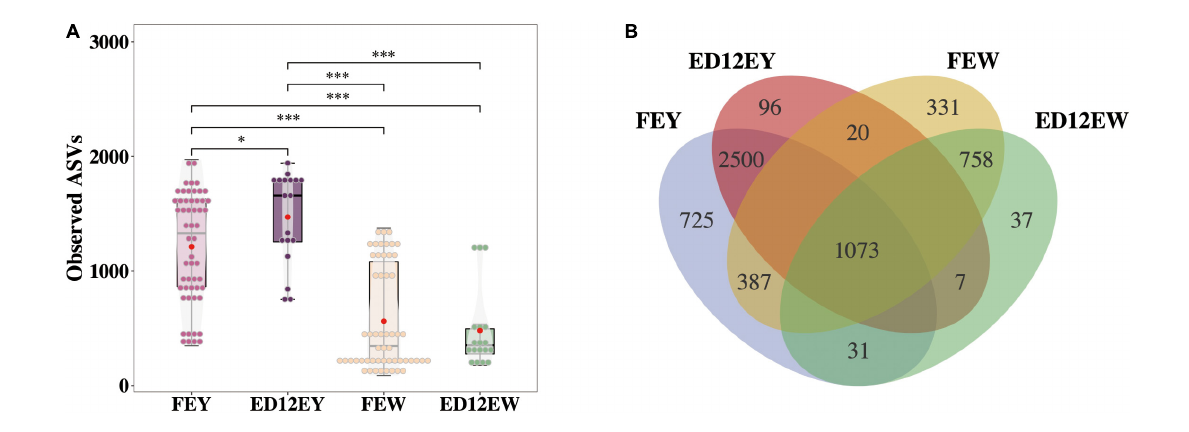
FIGURE2 The number of amplicon sequence variants (ASVs) and the shared ASVs in different groups. (A) The boxplot depicts the total number of ASVs detected in each group. (B) A Venn diagram demonstrates the core ASVs among four groups. * P < 0.05, *** P < 0.001, and ns means no significance.